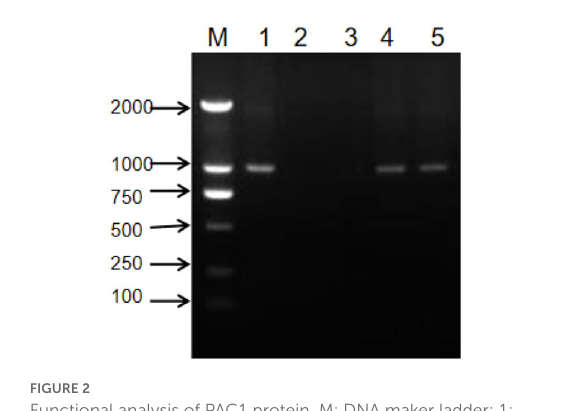
FIGURE2 Functional analysis of PAC1 protein. M: DNA maker ladder; 1: artificially synthesized double-stranded RNA; 2: 10min after degradation; 3: 30min after degradation; 4: 10min without degradation but with the same treatment process; 5: 30min without degradation but with the same treatment